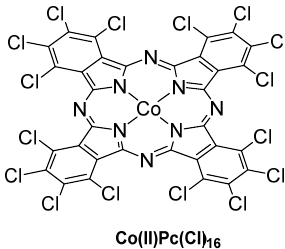
Figure 9. Example of a perchlorinated cobalt phthalocyanine, Co(II)Pc(Cl) 16 , used by Zhang and coworkers for the desulfurization of model fuels and gasoline.